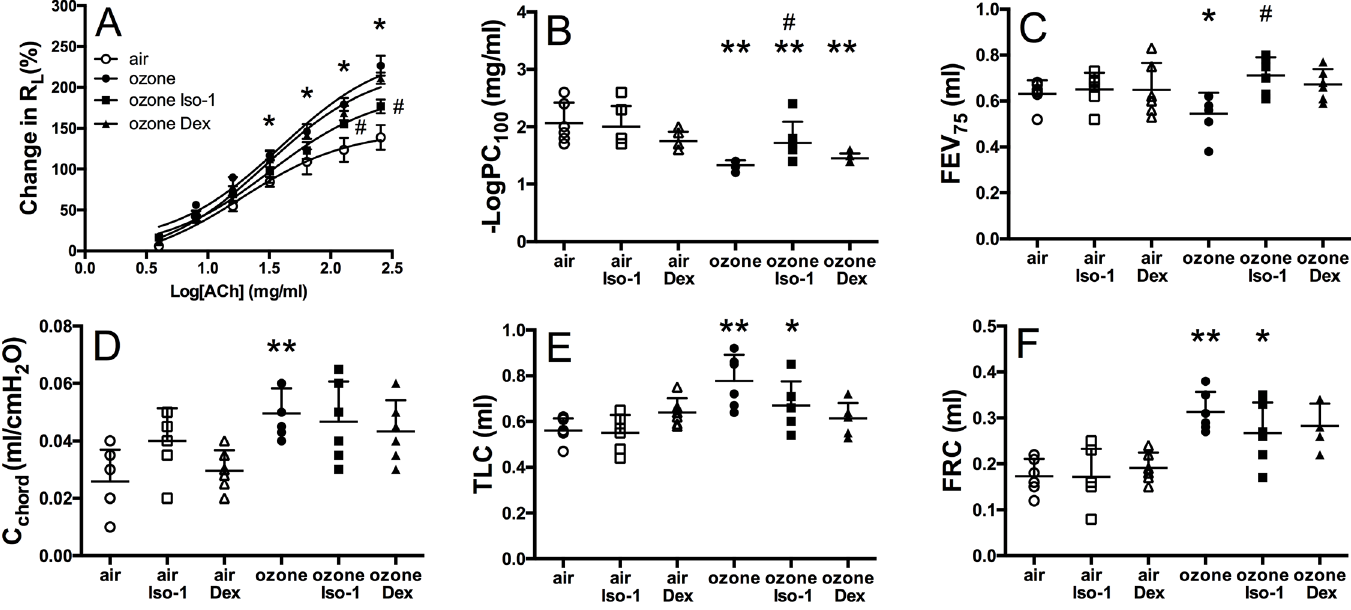
Fig 6. Effect of ISO-1 and dexamethasone on ozone-induced changes in AHR and lung function. Mouse lung function measurements of pulmonary resistance (R L ; A), -logPC 100 (B), FEV 75 (C), lung compliance (C chord ; D), total lung capacity (TLC; E) and functional residual capacity (FRC; F). Data are expressed as mean ± SD for 6 animals per group. * p < 0.05 and ** p < 0.01 compared to air controls, # p < 0.05 compared to ozone-exposed group.